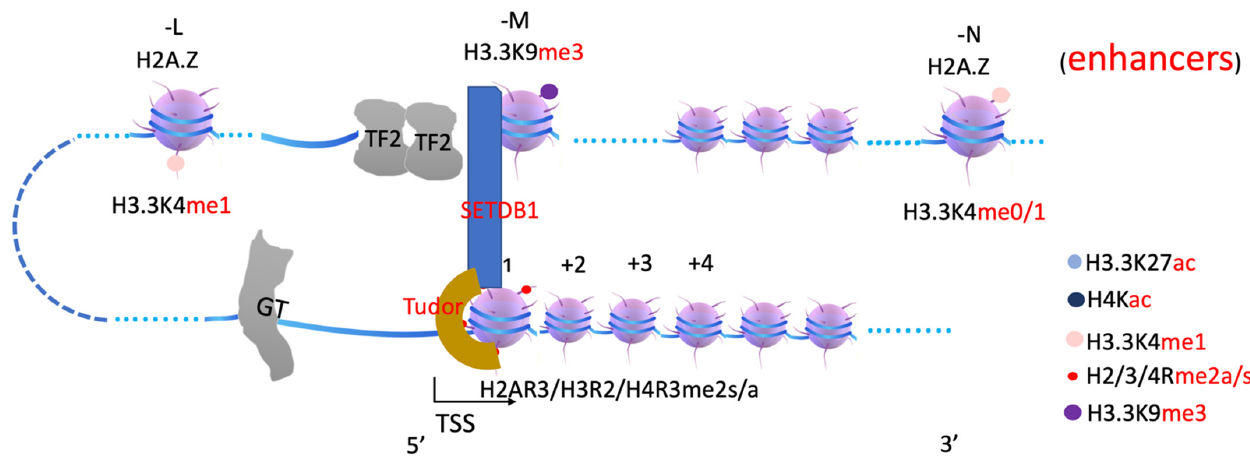
Figure 7. A model of how SETDB1 is recruited by arginine methylated histone on +1 nucleosome. SETDB1 will be recruited through the Tudor domain within SETDB1 and methylates H3.3K9 to generate H3.3K9me3. H3.3K9me3, trimethylated H3.3K9.